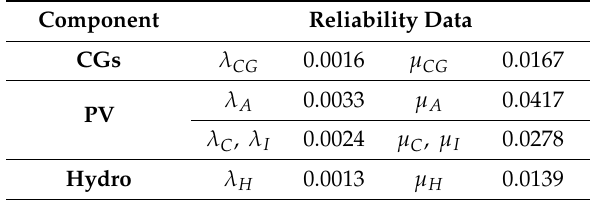
Table 2. Reliability Data for Each Component.